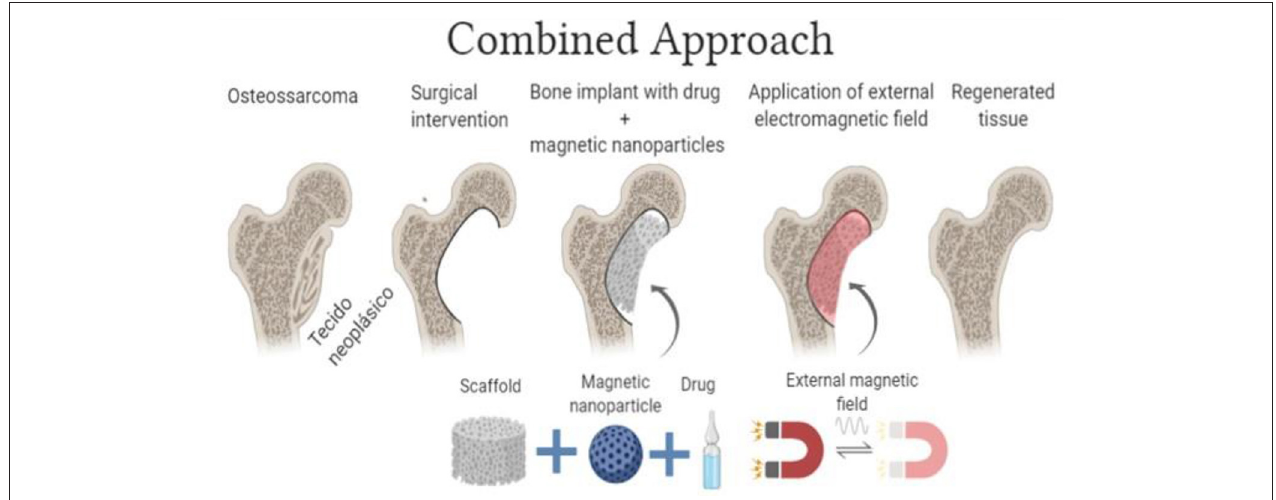
FIGURE 3 | Schematic illustration of the combined approach (bioceramics scaffolds combined with an anti-tumor drugs) and MNPs (Image Source: created using BioRender).